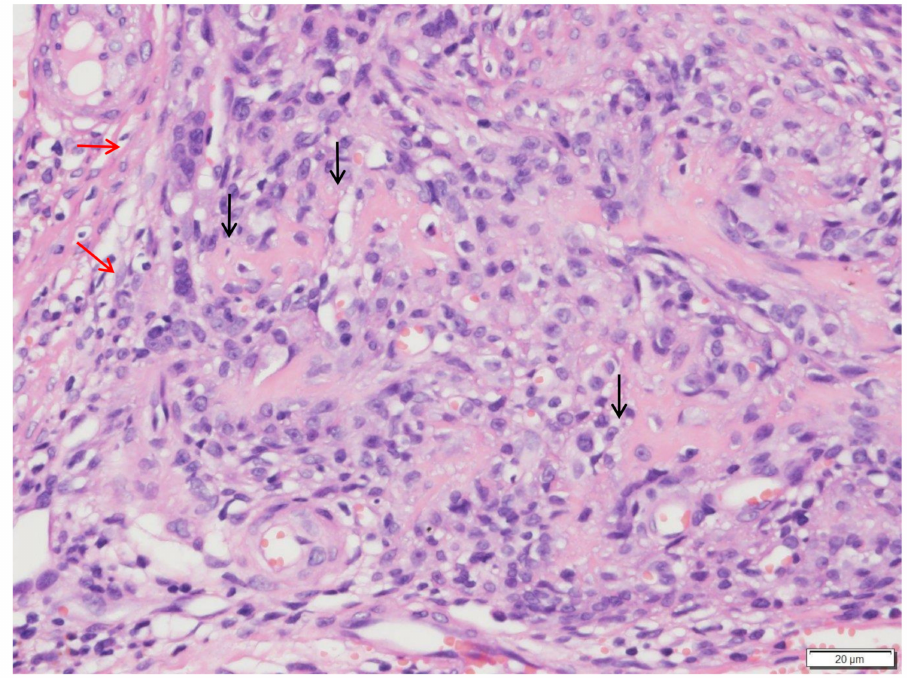
Figure 7. Histologic findings of the vertebral body mass. Occasional multinucleated cells (red arrows) and osteoid islands (black arrows) are noted. Hematoxylin and eosin stain ( × 400 magnification). On completion of doxorubicin treatment, toceranib phosphate 10 mg was